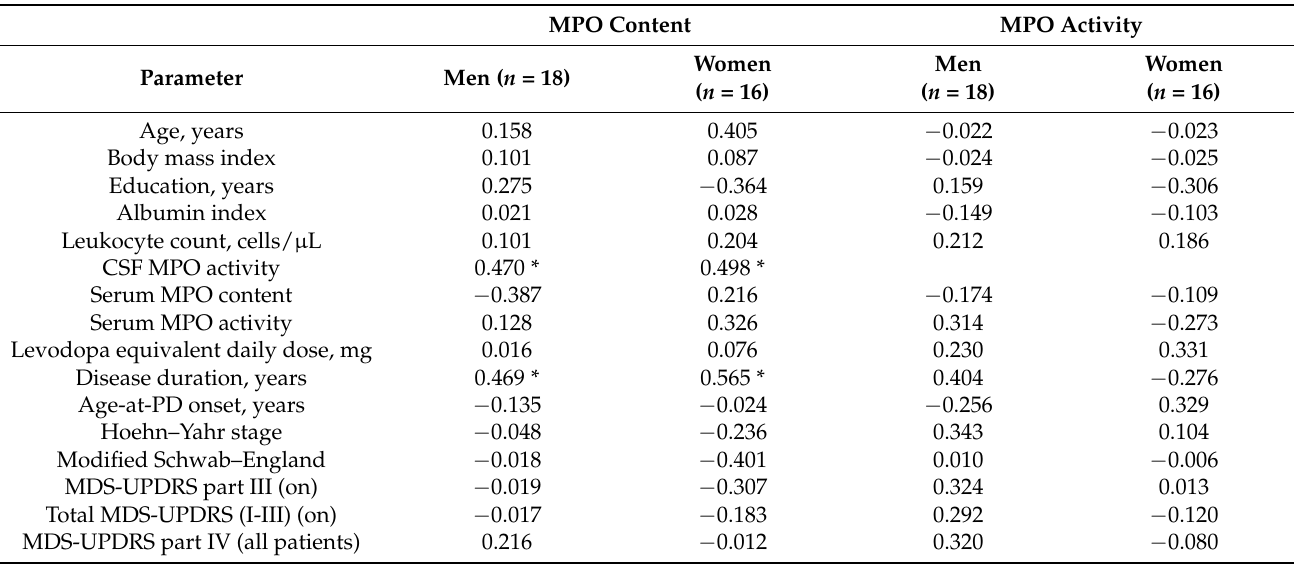
Table 4. Correlation of MPO concentration and activity in the CSF with demographic and clinical parameters in male and female patients with idiopathic Parkinson’s